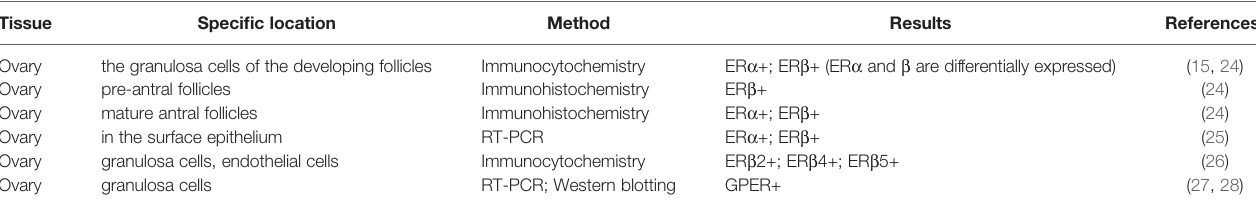
TABLE 1 | Expression of ERs in normal ovary